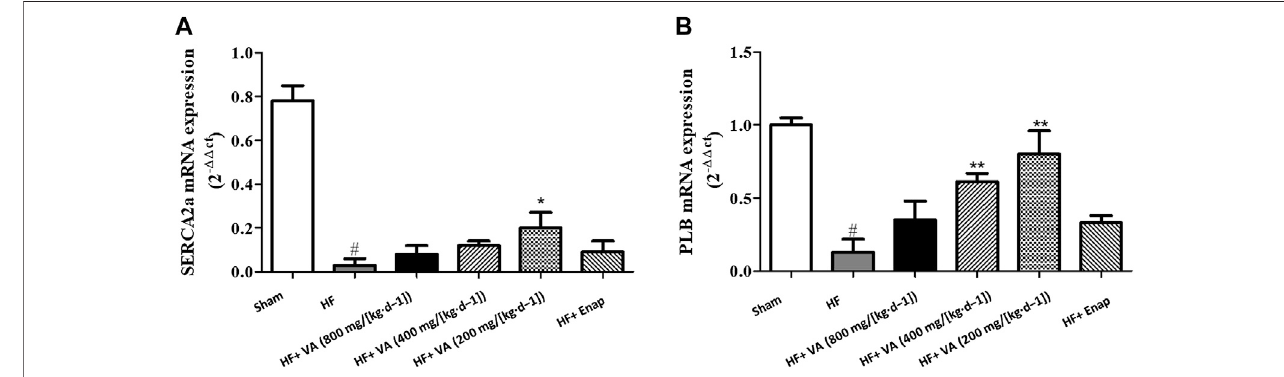
FIGURE 5 | The effect of velvet antlers (VA) on SERCA2a (A) and PLB (B) mRNA expression. The data are expressed as means ± SEM. #: p < 0.01 vs. the sham group; *: p < 0.05 vs. the heart failure (HF) group; **: p < 0.01 vs. the HF group. n (cid:1) 6. Enap: enalapril.